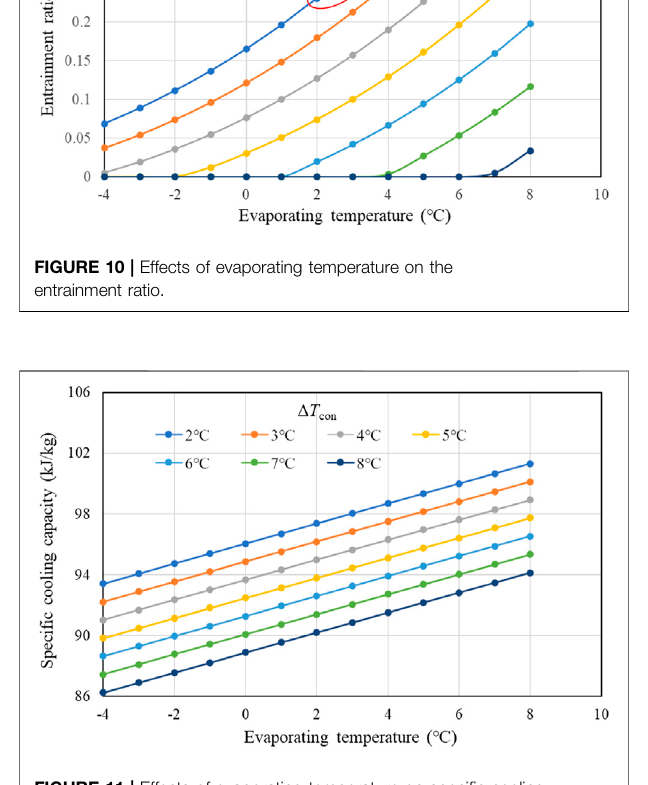
FIGURE 11 | Effects of evaporating temperature on speci fi c cooling capacity.